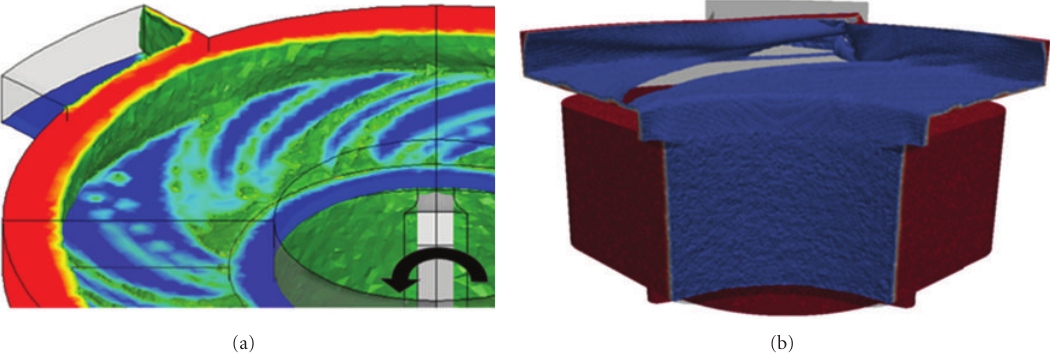
Figure 10: (a) Snapshot of free surface flow over the upper weir at high flow rate showing liquid accumulation under weir cap [143], (b) Snapshot of free surface flow over the upper weir at high flow rate showing liquid accumulation under weir cap [165].